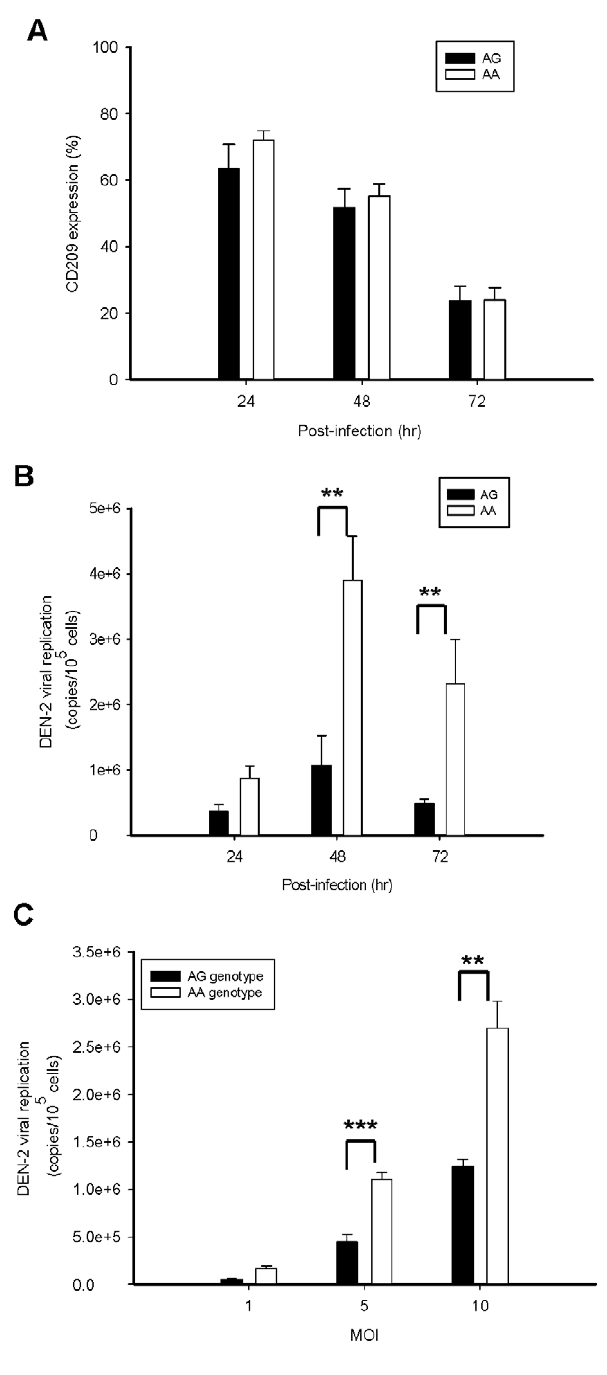
Figure 2. Kinetic surface CD209 expression and viral replica- tion from DEN-infected MDDCs with AA or AG genotype. (A) Kinetic CD209 surface expression on MDDCs from individuals with AA or AG genotype of rs4804803 by flow cytometry. The surface CD209 expression declined along with infection in subjects with both genotypes. (B) Kinetic changes of DEN-2 replication (virus copies per 10 5 cells) were assessed after infection at MOI of 5 for 24 to 72 h. Viral replication was significantly higher in MDDCs from individuals with rs4804803 AA genotype than those with AG genotype at 48 hr and 72 hr post-infection ( p =0.006 and 0.003, respectively) The results are shown as mean 6 s.e.m. from subjects with AA (n=8) or AG (n=8) genotype in three independent experiments. (C) Changes in the yield of DEN-2 replication (virus copies per 10 5 cells) were assessed at MOIs of 1, 5, and 10 at 72 h post-infection. Viral replication was significantly